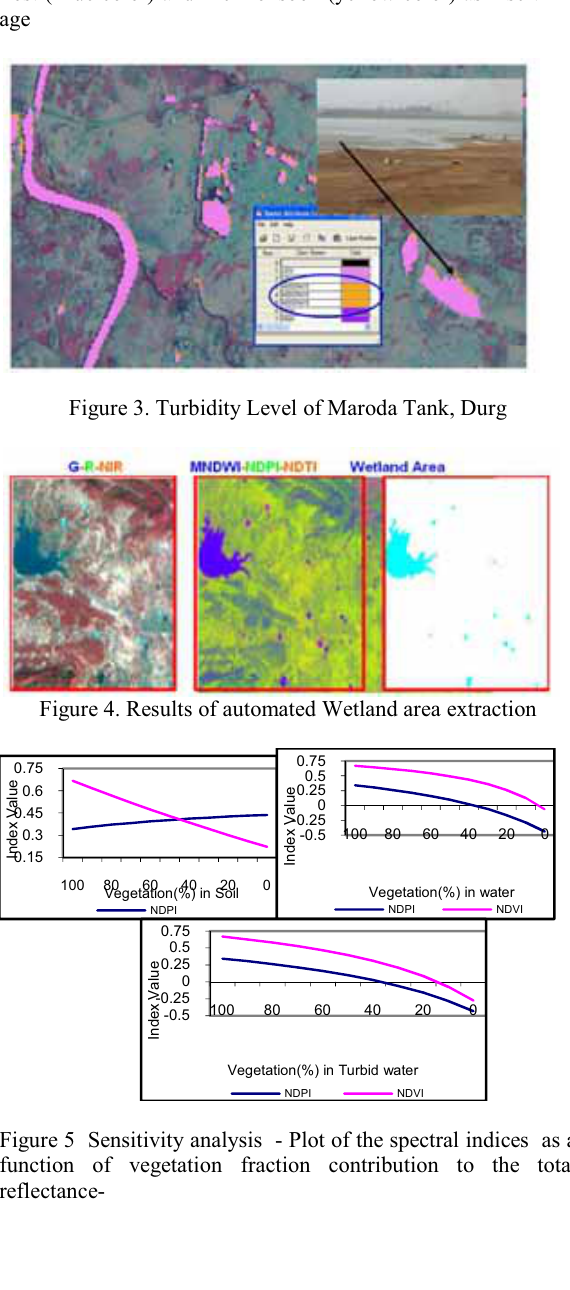
shows variation in water spread in Tandula reservoir. The clas- sified image of May shows the seasonal change in water spread Post (Blue color) and Pre monsoon (yellow color) as insert im-